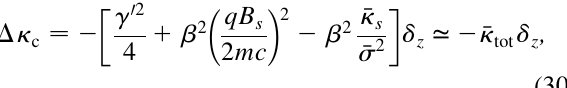
(cid:1) (cid:1) ^ (cid:1) in blue, and nonlinear terms (cid:6)(cid:1) 2 (cid:1) (cid:2) s